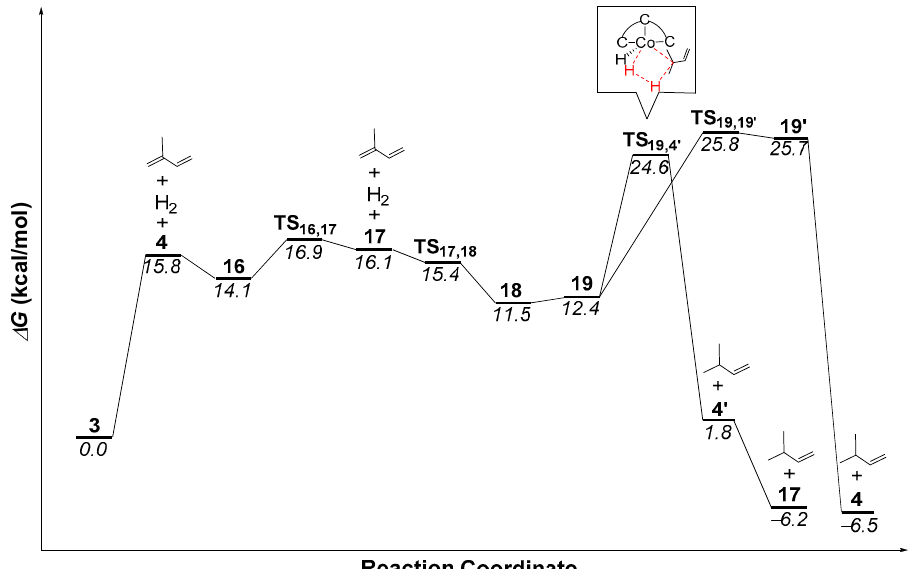
Figure 7. Free energy profile for the hydrogenation of isoprene to 3-methylbut-1-ene catalyzed by ( Mes CCC)Co complexes.